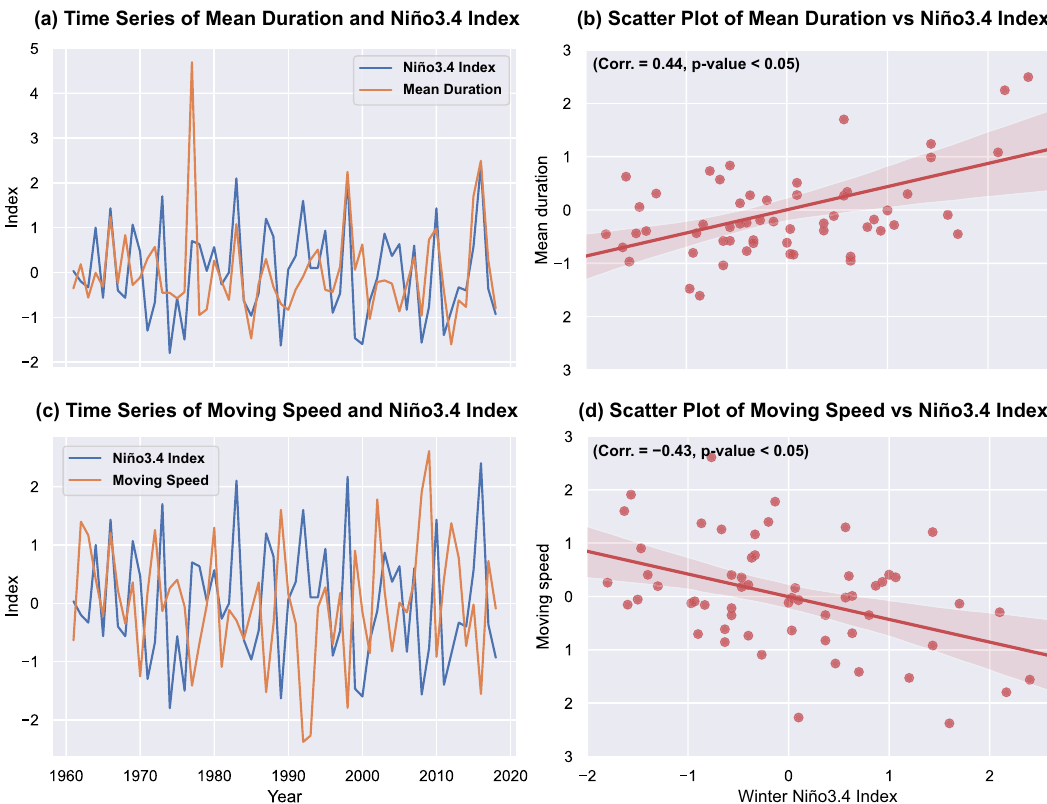
Fig. 6 Relationship between Type 1 contiguous heatwaves metrics and the winter Niño3.4 index. a , c Time series of the mean duration ( a ) and moving speed ( c ) of Type 1 contiguous heatwaves and the winter Niño3.4 index. b , d Scatter plots of the mean duration ( b ) and moving speed ( d ) of contiguous heatwaves versus the winter Niño3.4 index, with the straight line indicating their corresponding fi tted line estimated by the simple linear